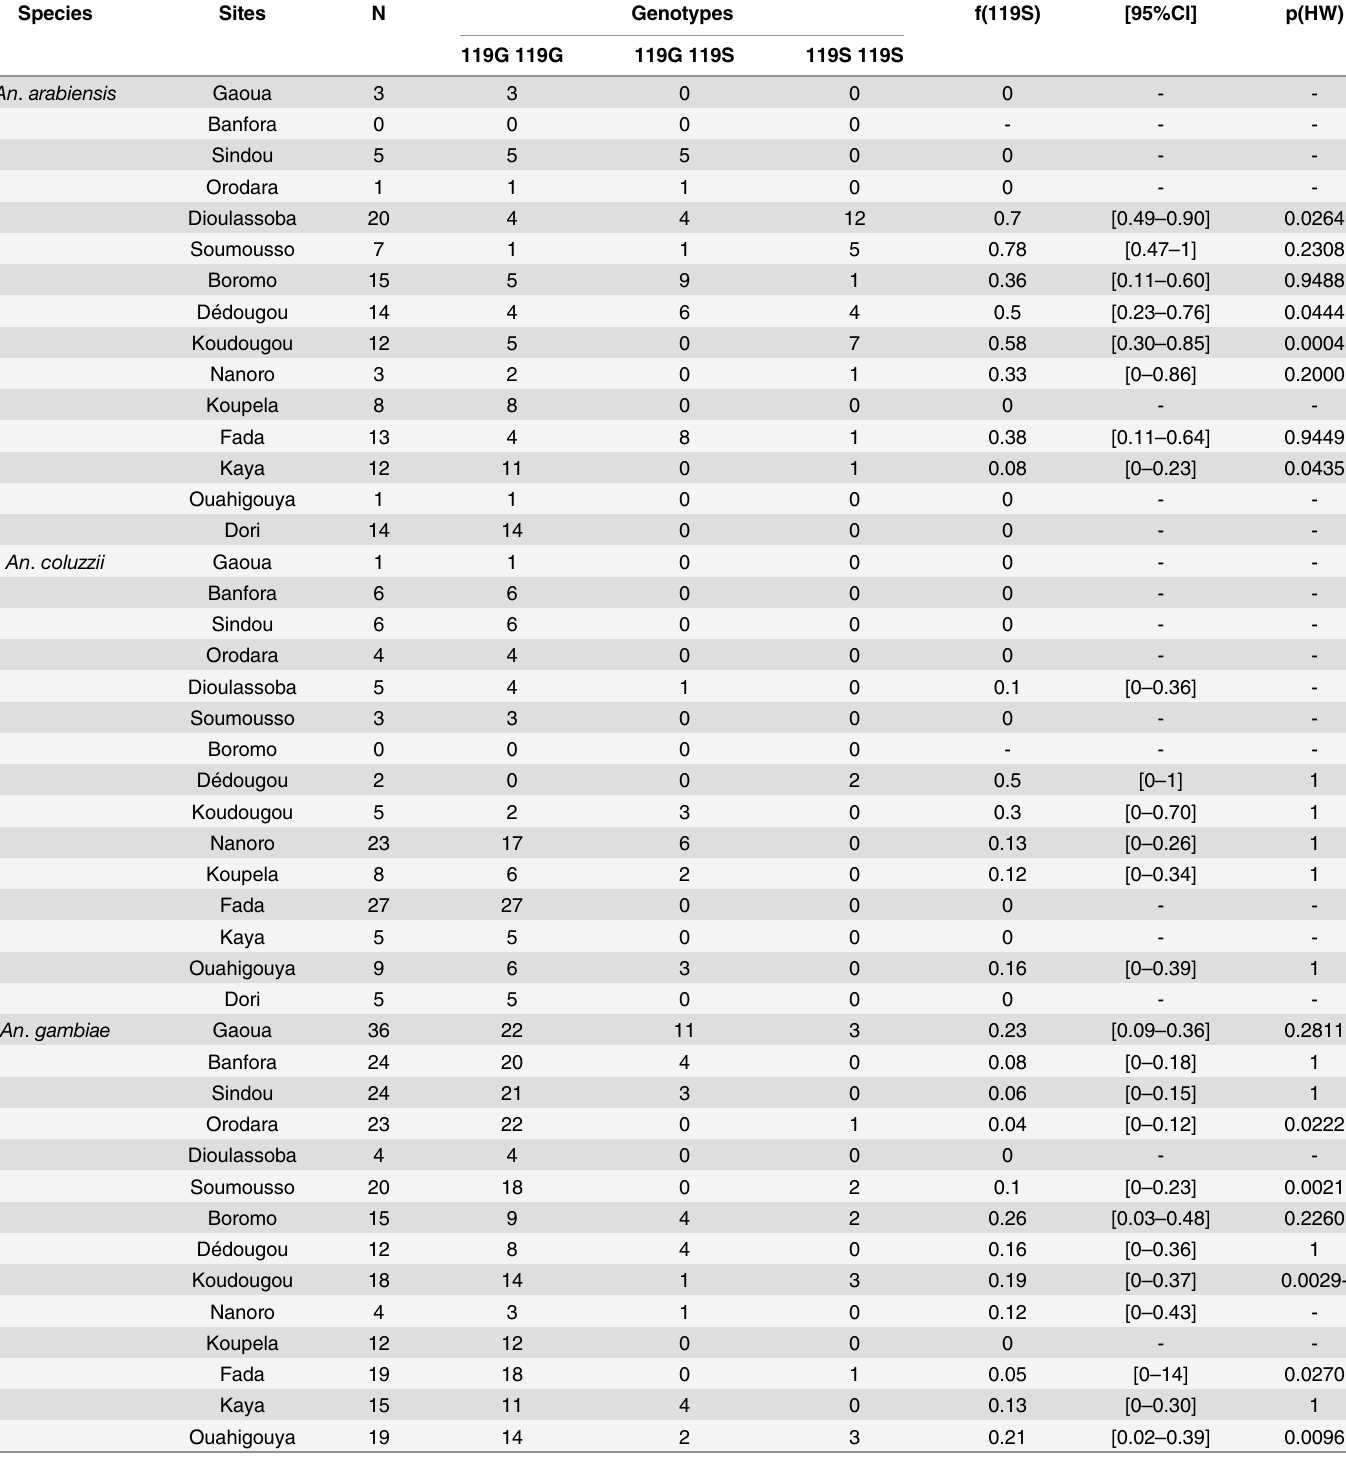
Table 3. Allelic and genotypic frequencies at the ace-1 locus in An . gambiae s . l populations from 15 sites in Burkina Faso.